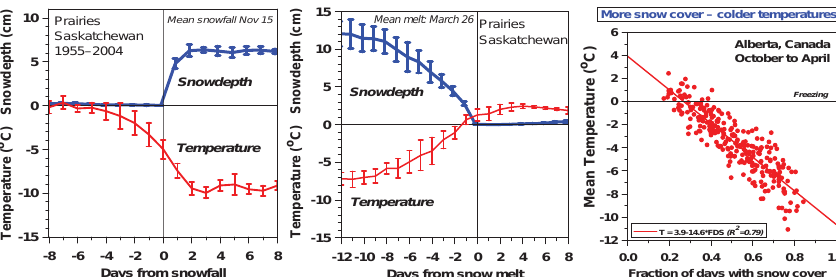
Figure 3. Fall (left panel) and spring (center panel) snow transition for six Saskatchewan stations, and (right panel) relation of cold season temperature to fraction of days with snow cover for five Alberta stations.